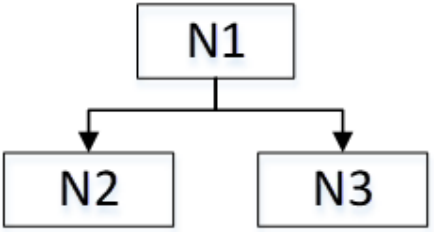
Figure 3. Schematic diagram of wavelet packet decomposition tree at level 3.